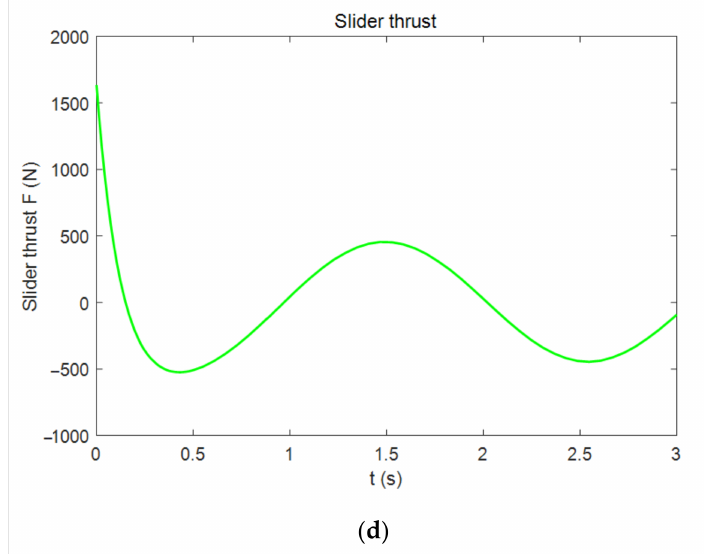
Figure 4. The variable fluctuations of all six iterations and those of the last iteration ( a ), the maximum absolute value of errors of variable fluctuations in the three iterations ( b ), the speed fluctuations of the last iteration and speed errors during the three iterations ( c ), and the force fluctuation of the slider thrust ( d